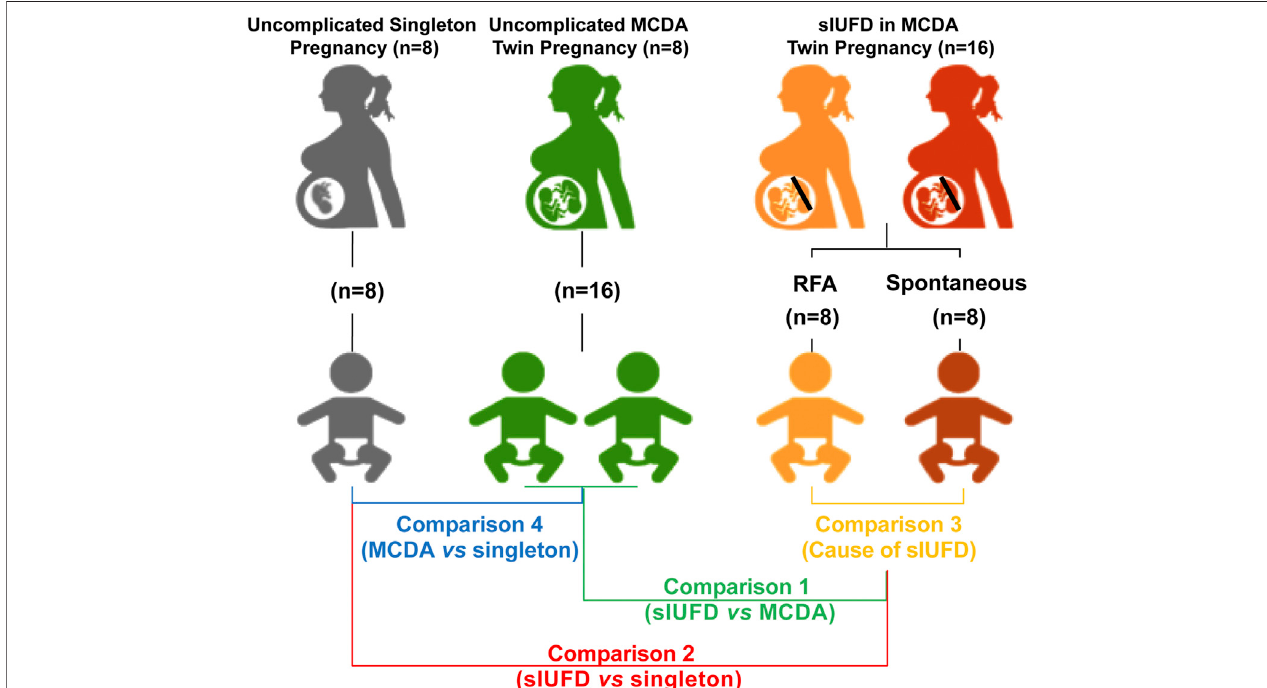
FIGURE 1 | Schematic diagram of study design. The study cohorts (with their representative colors) are as follows: sixteen sIUFD MCDA cases, namely, eight spontaneous sIUFD cases (red) and eight post-RFA sIUFD cases (orange), were included; eight maternal age-matched uncomplicated MCDA twin pregnancies (16 neonates, green) and eight age-matched uncomplicated singleton pregnancies (grey) were also selected. The four comparisons (with corresponding iconic colors) are C1 (green): (RFA + Spontaneous) vs. MCDA; C2 (red): (RFA + Spontaneous) vs. Singleton; C3 (orange): Spontaneous vs. RFA; C4 (blue): MCDA vs. Singleton. Abbreviations: MCDA, monochorionic diamniotic; sIUFD, single intrauterine fetal death; RFA, radiofrequency